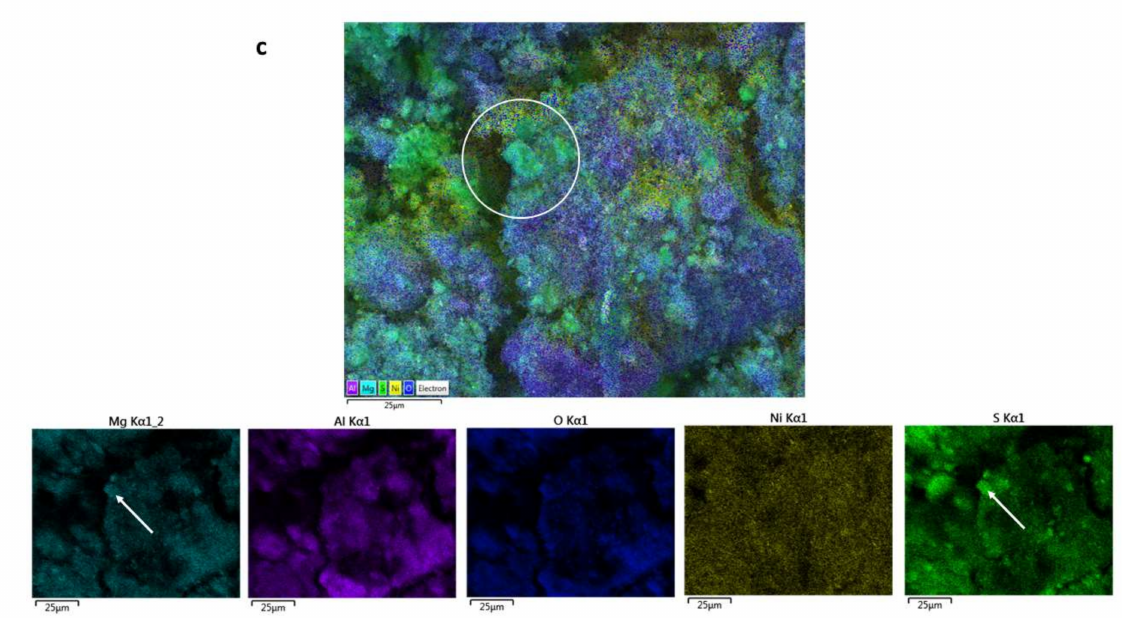
Figure 4. X-ray mapping of ( a ) Ni/MgAl 2 O 4 -S1-200, ( b ) Ni/MgAl 2 O 4 -S1-400 and ( c ) Ni/MgAl 2 O 4 - S1-550. Evidence of sulfur interacting with MgAl 2 O 4 indicated by white